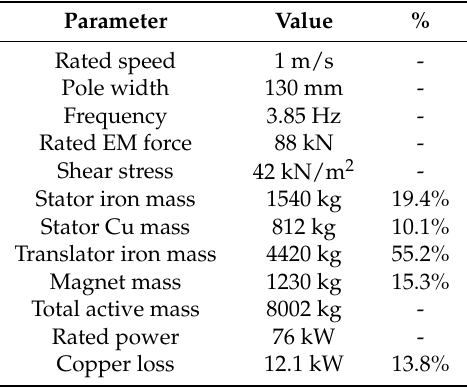
Table 1. Properties of the designed